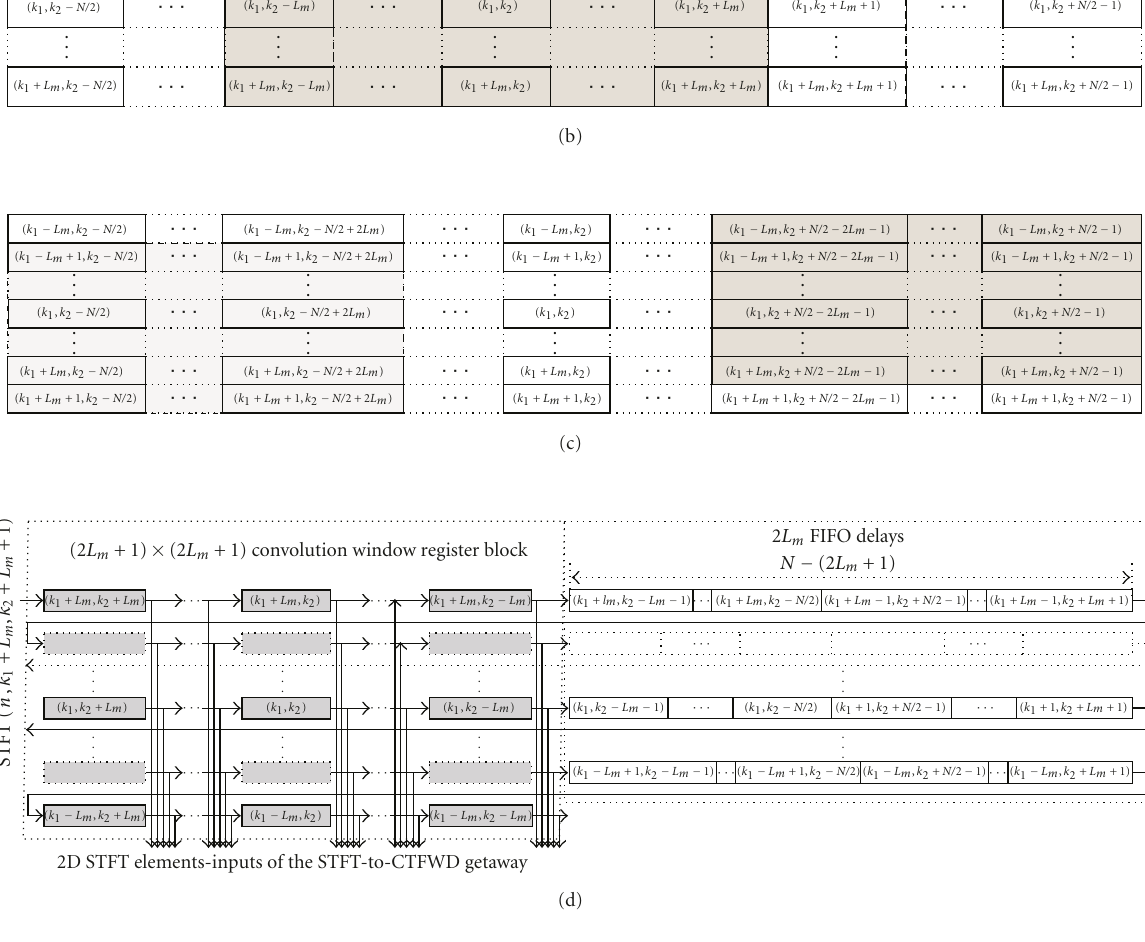
Figure 6: (a) Procedure of 2D convolution window sliding and of 2D CTFWD producing; (b) Actual convolution window position corresponding to the point ( k 1 , k 2 ) (thick solid line) and its next position (thick dashed line); (c) Actual convolution window position (thick solid line) and its next-left border-position (thick dashed line); (d) Convolution window function, implemented in real time. Cells correspond to the 2D STFT elements, denoted by their position in frequency-frequency